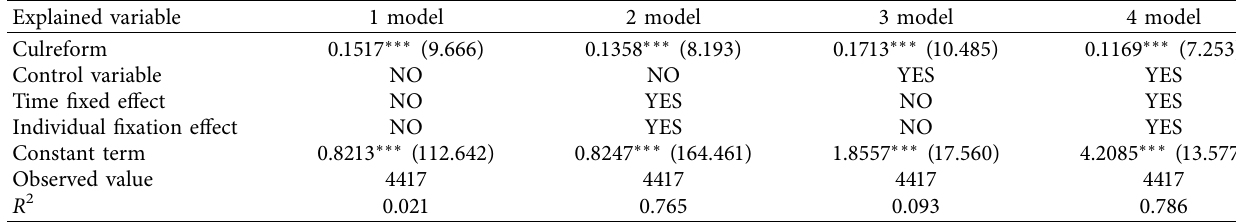
Table 5: PSM-DID regression results.